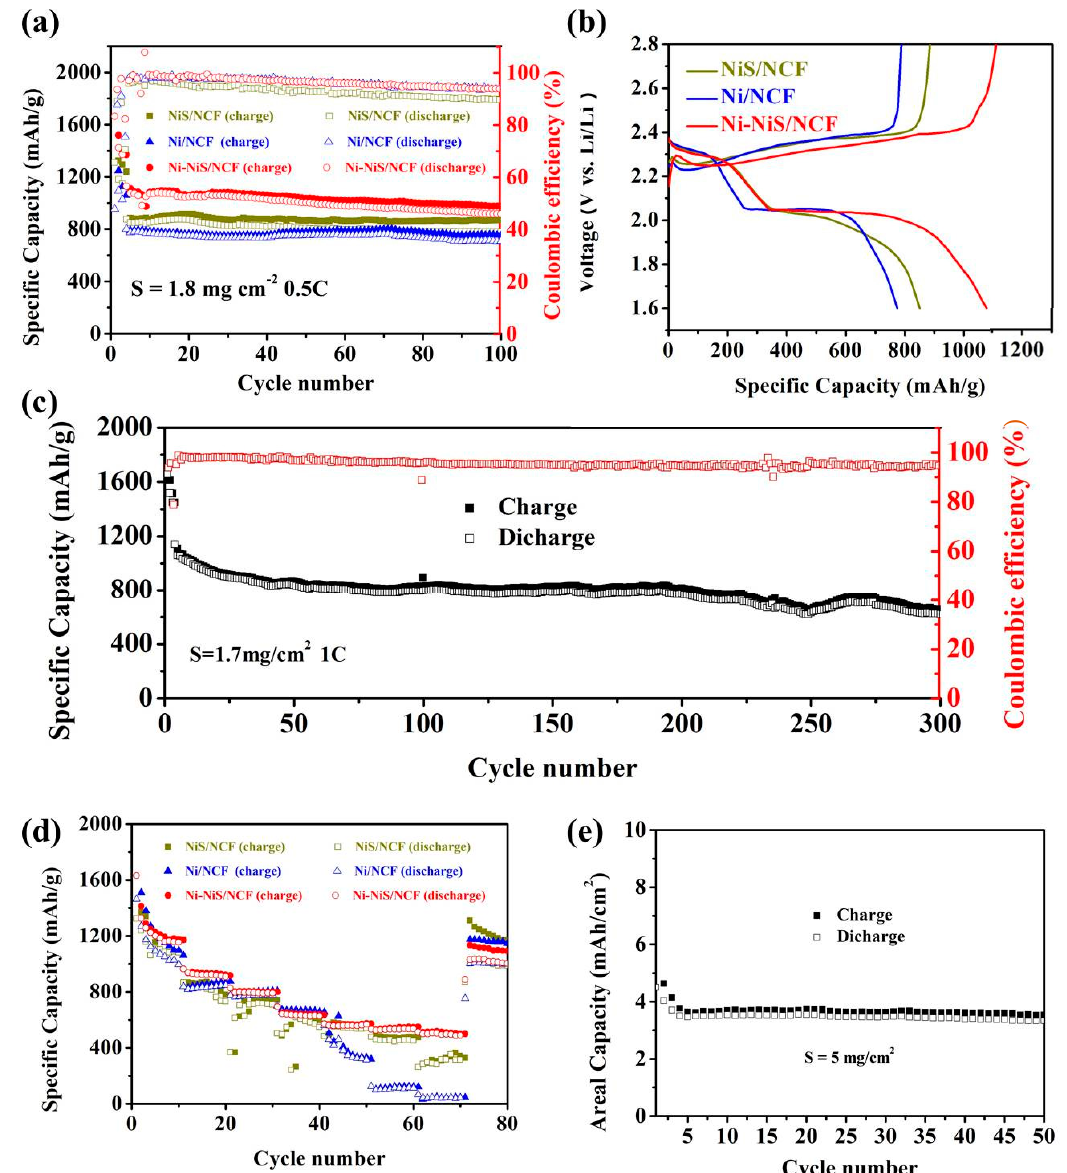
Figure 6. ( a ) Cycling performance of the cells with different separators at 0.5 C. ( b ) Charge and discharge curves of the cells with different separators at 0.5 C. ( c ) Long cycle performance of the cell with Ni-NiS/NCF-coated separator at 1 C. ( d ) Rate performance at different current densities for different cells. ( e ) Cycle performance of the cell with Ni-NiS/NCF-coated separator at 0.1 C with high sulfur load.